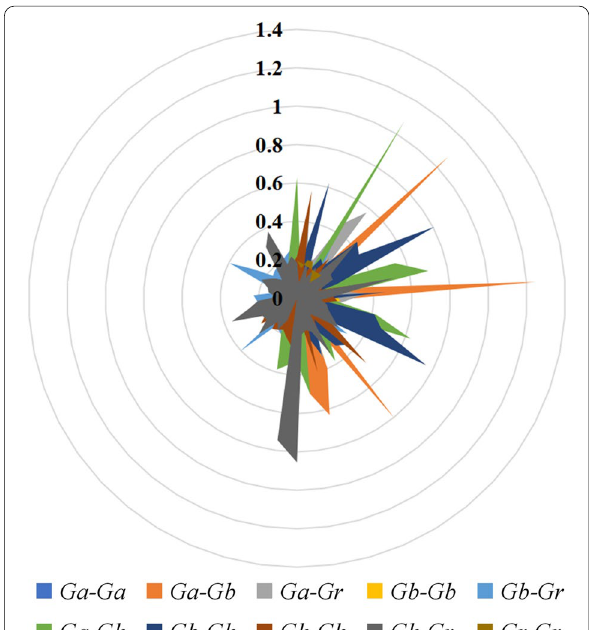
Fig. 4 Analysis of Non-synonymous ( Ka ) to Synonymous ( Ks ) ratio. Non-synonymous ( Ka ) and synonymous ( Ks ) divergence values for Ga – Ga , Ga – Gr , Ga – Gb , Ga – Gh , Gb – Gb , Gb – Gh , Gb – Gr , Gh – Gr , Gh – Gh and Gr – Gr are shown in circular